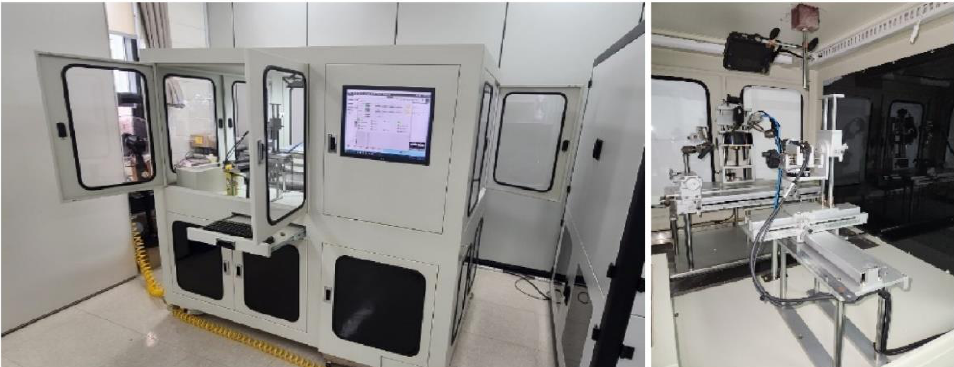
Figure 3. Blockage performance evaluation device.